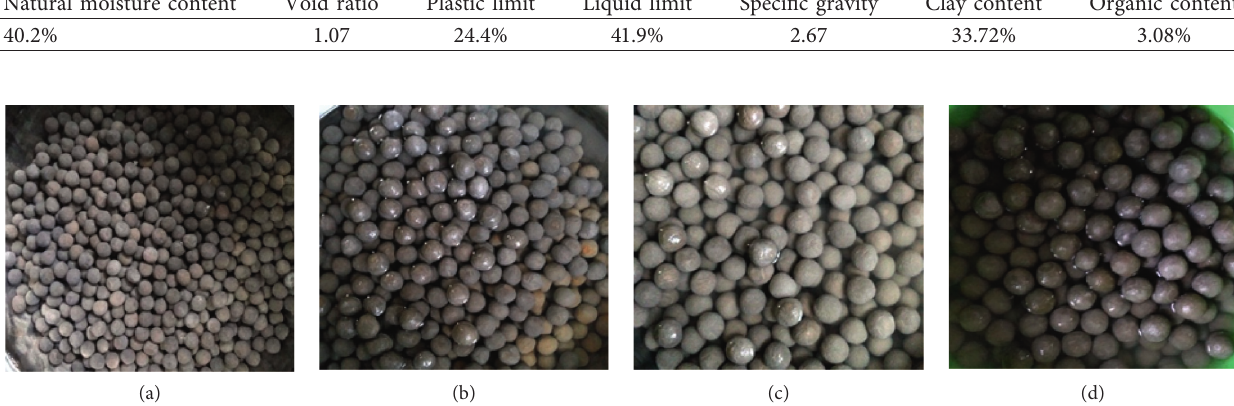
Figure 4: Miscellaneous fill materials with different particle sizes (spherical cement particles). (a) 15mm. (b) 25mm. (c) 35mm. (d) 45mm.